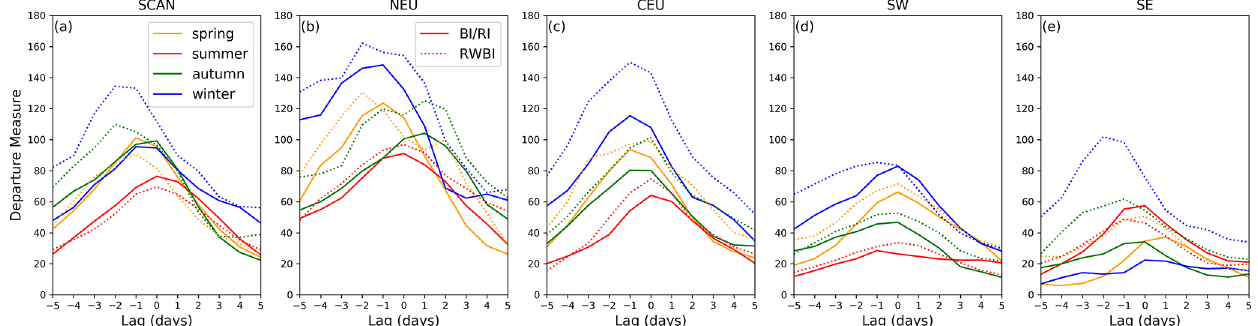
Figure 4. Departure measures for the blocking or ridge index (solid lines) and the Rossby wave breaking index (dotted lines) during stagnation for each season as a function of lag from stagnant days in (a) SCAN, (b) NEU, (c) CEU, (d) SW and (e) SE. The blocking index is shown for SCAN, NEU and CEU and the ridge index for SW and SE.